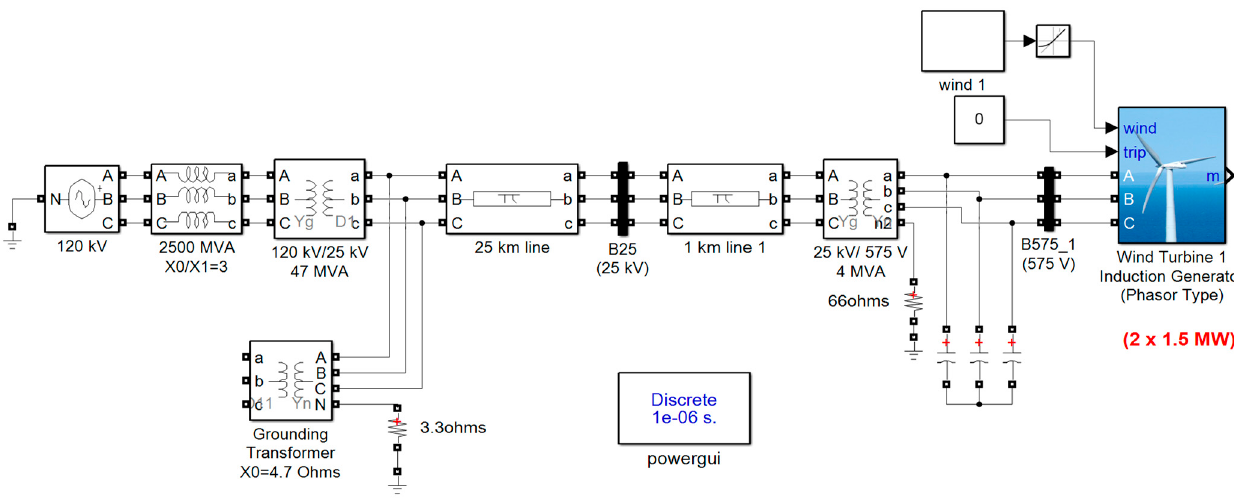
Table 5. Individual parameters of the wind power grid.